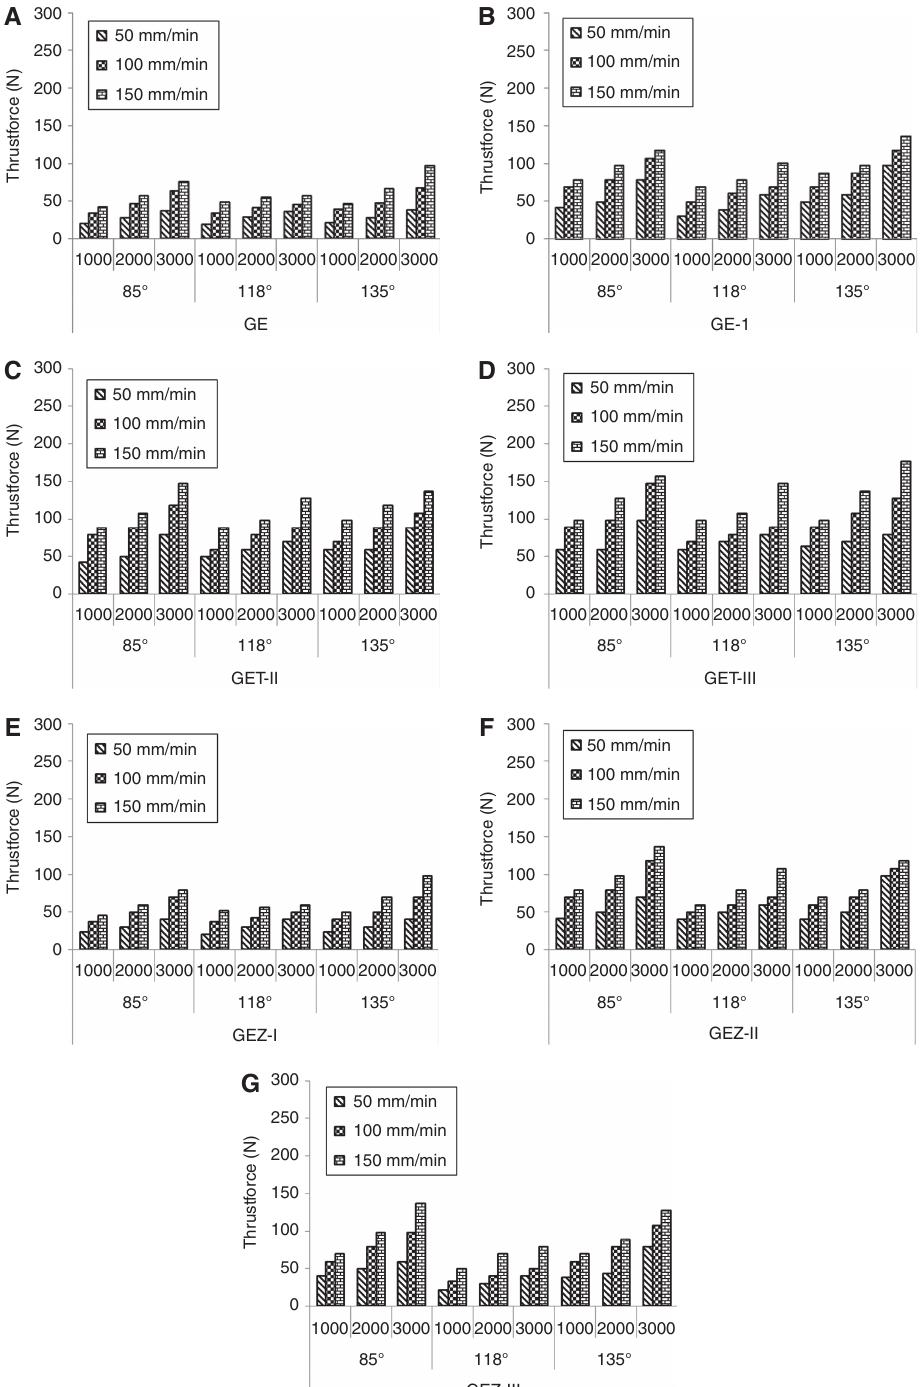
- and ZnS-filled GFRP 2